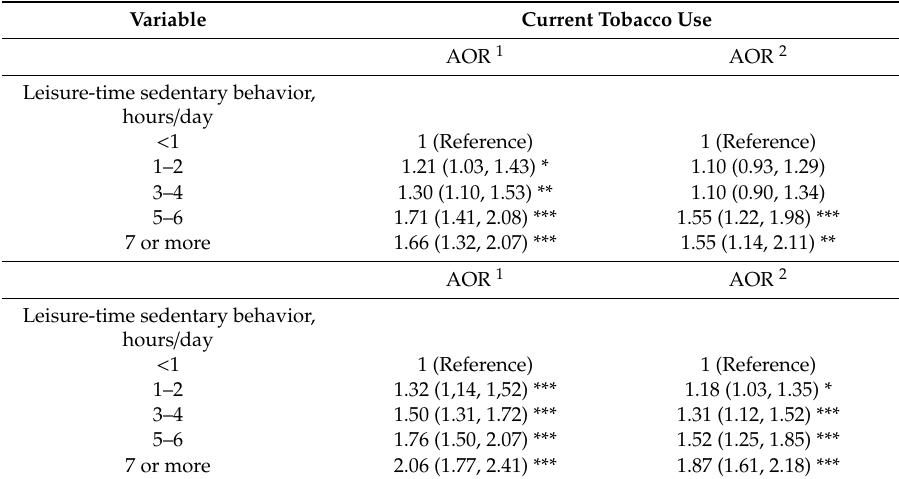
Table 4. Associations between leisure-time sedentary behavior and tobacco and alcohol use.